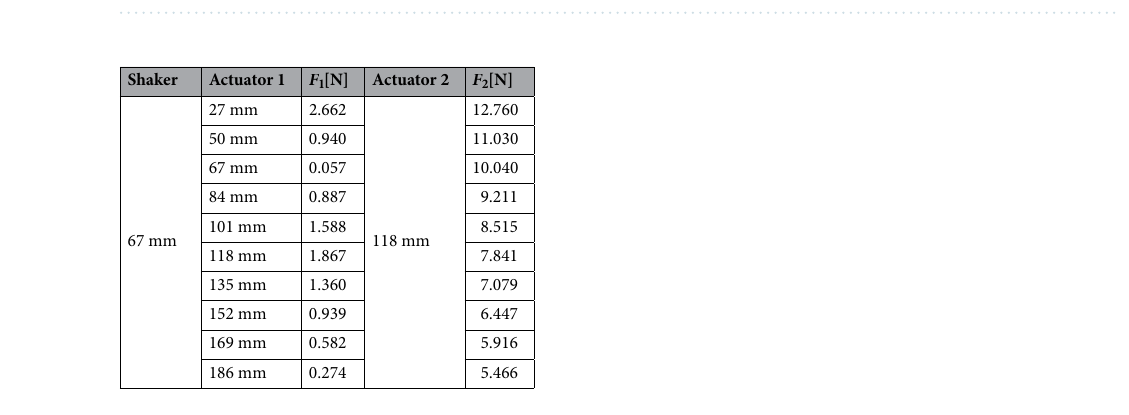
Figure 16. Control force of actuators 1 and 2 when the shaker is placed at 110 mm: ( a ) actuator 1; ( b ) actuator 2 ( generated with MATLAB R2018b, https:// mathw orks. com).